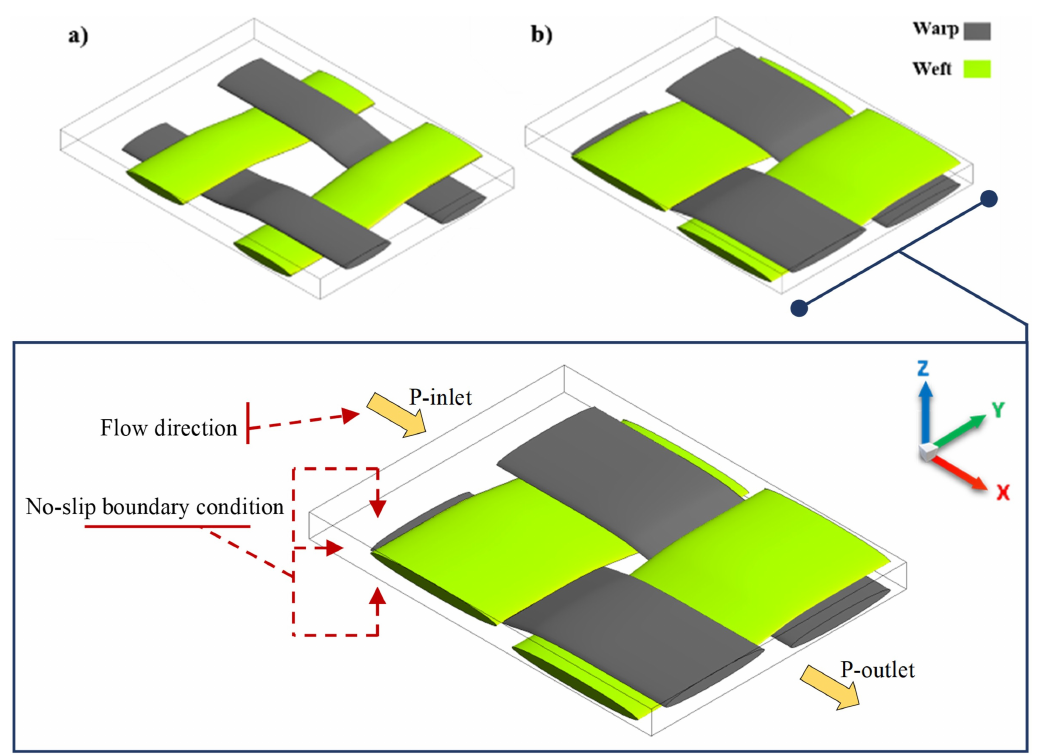
Figure 7. UC of 2D woven fabric with different inter-tow porosity of ( a ) φ s = 66% (modified yarns cross-section 1.4 mm wide in warp and 1.8mm wide in weft direction, with a spacing of 1.39mm and 1.34mm, respectively), and ( b ) φ s = 44% (geometrical details presented in Table